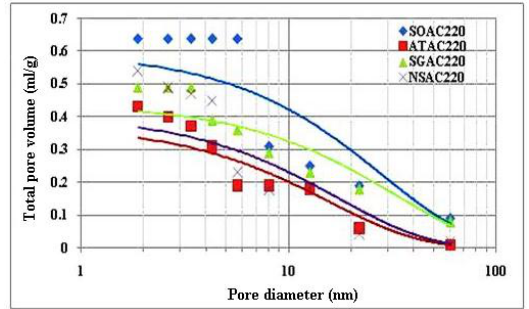
Figure 3. The total pore volume curve of Shivee Ovoo, Alagtogoo, Sharyn gol and Naryn sukhait active carbons. (activation time 220 min)